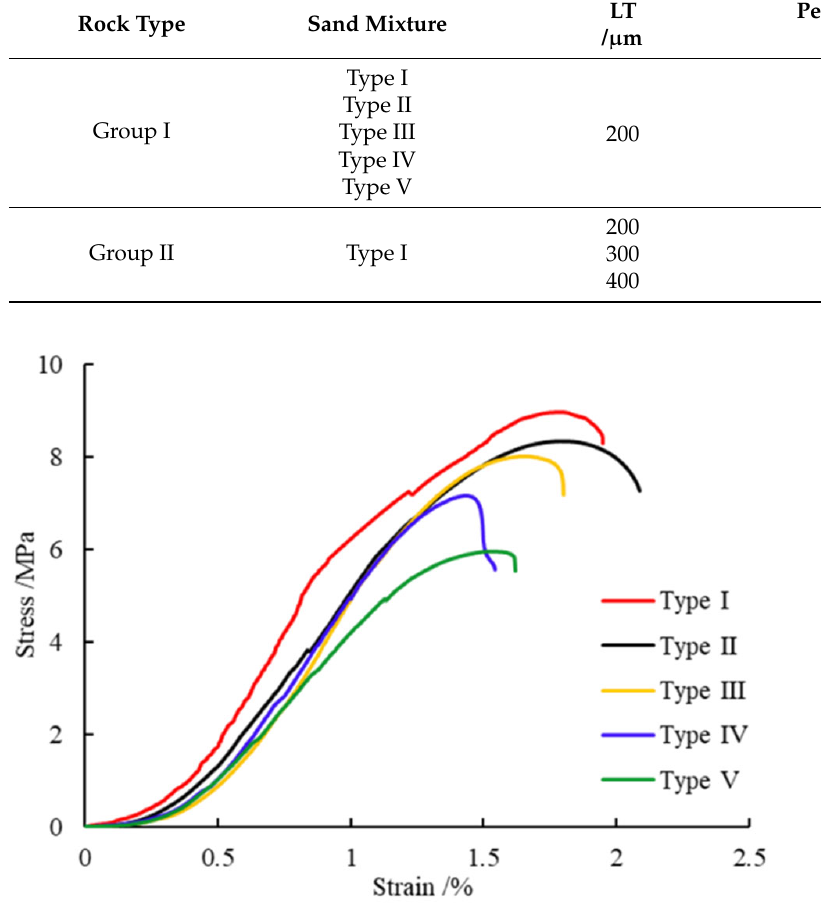
Figure 9. Stress–strain curves of the 3DP rock analogs printed with different blends of sand mixtures. The failure patterns of the 3DP rocks printed with different blends of sand mixtures are plotted and re-drawn in Figure 10. For the specimens with a higher percentage of CG, the tensile failures with shear cracks at the end of the cores are the main failure mode (Type I~III). These phenomena are also named as the “end cap” cone, which has been reported in a previous study, i.e., a failure zone with a cone shape at the end of the core [39]. There are multiple crack planes and many sand grains fall down from the crack planes during compression. Finally, the specimen breaks into several fragments. With the increment in the FG, the specimens mainly experience compression shear damage with a main shear crack plane through the core, which exists at a certain inclination angle with the loading direction (Type